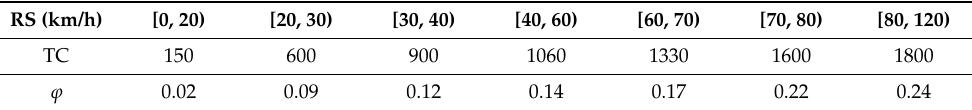
Table 4. The actual road network capacity mapping